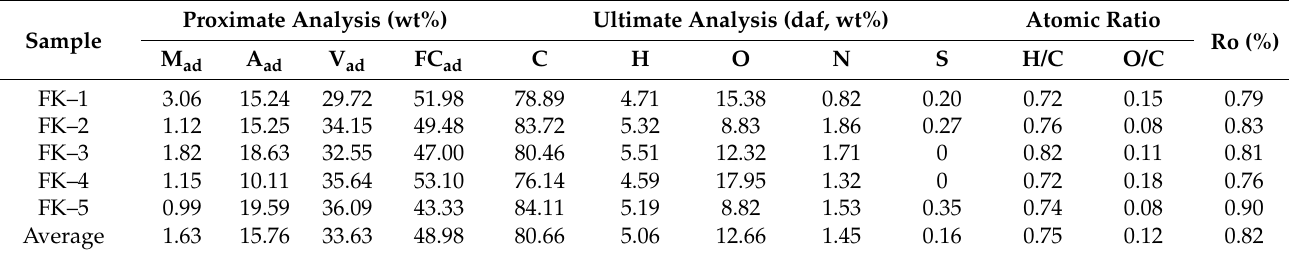
Table 1. Property analyses of the coals.